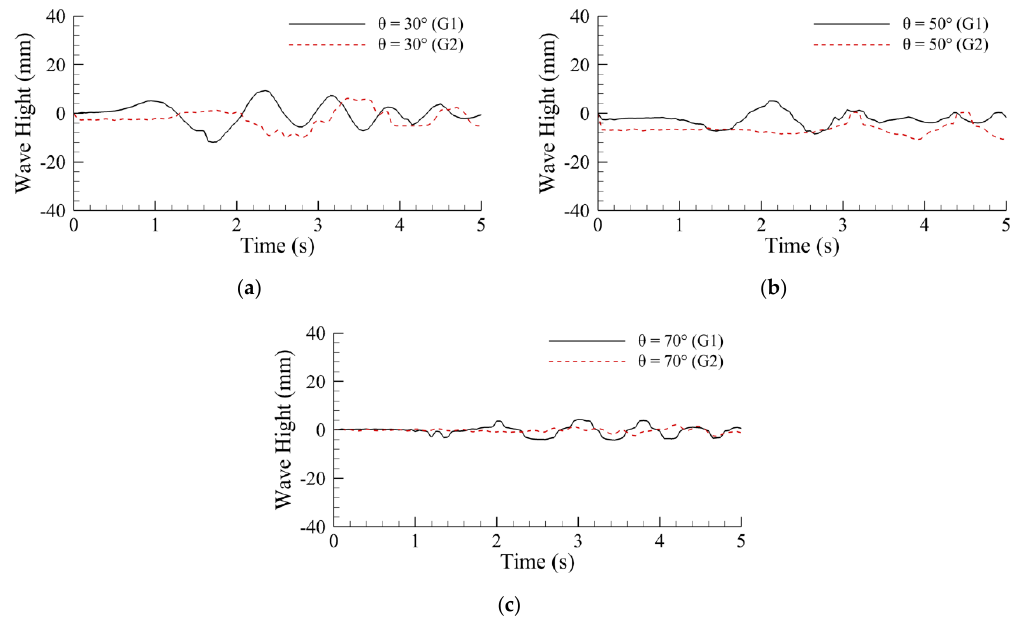
Figure 13. The temporal evolution of the water elevation in G 1 and G 2 with the submarine landslide: ( a ) θ = 30 ◦ ; ( b ) θ = 50 ◦ ; and ( c ) θ = 70 ◦